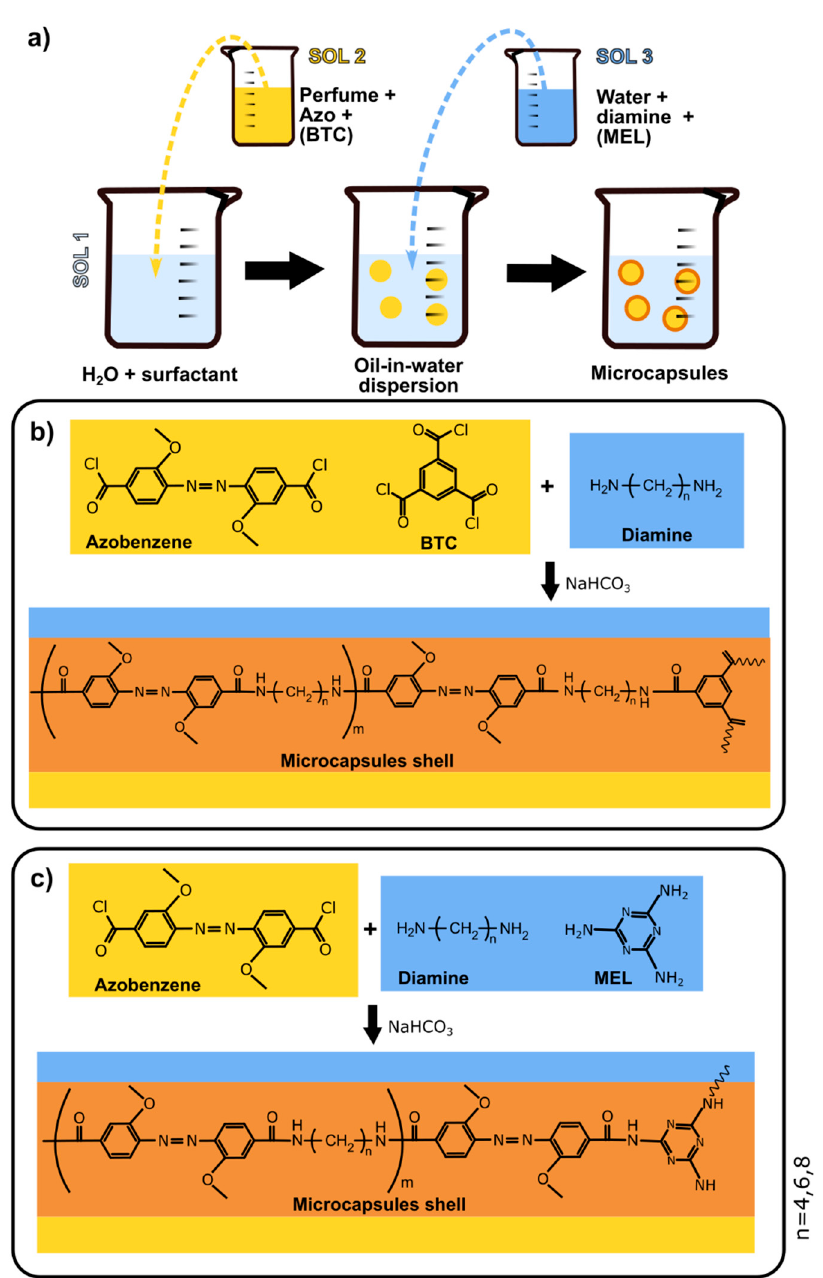
Figure 1. Schematic representation of ( a ) emulsion interfacial polycondensation and microcapsules shell formation using 1,3,5-benzenetricarbonyl trichloride (BTC) ( b ) and melamine (MEL) ( c ) as a cross-linker.